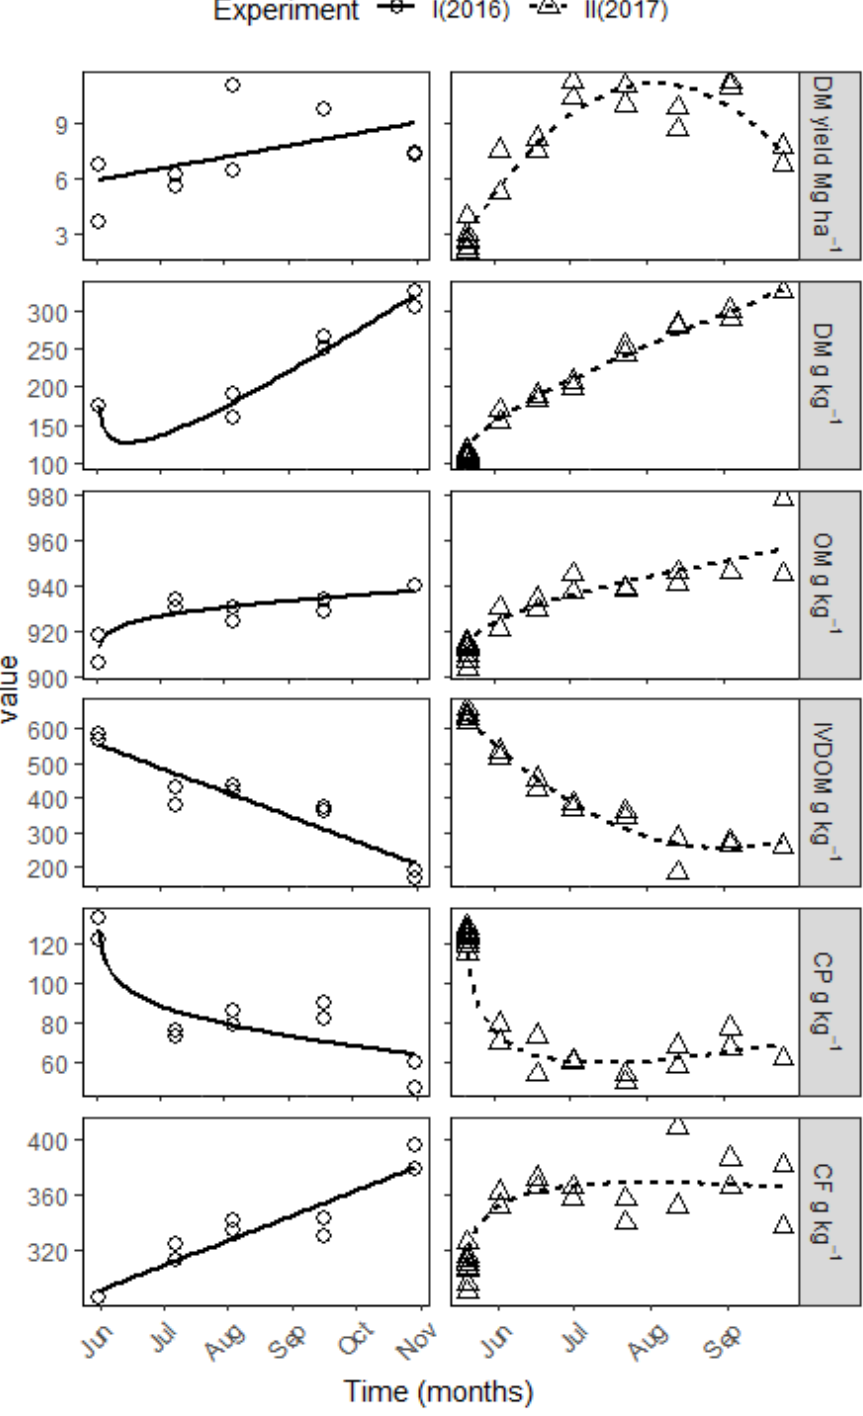
Figure 3. Experiments I and II: Effect of harvest day on dry matter (DM) yield and biomass DM, and on the dry matter contents of organic matter (OM), in vitro digestible organic matter (IVDOM), crude protein (CP) and crude fibre (CF) in T. latifolia biomass one year after planting. Harvest dates were 31 May, 07 July, 03 August, 15 September and 28 October 2016 for Experiment I and 19 May, 09 June, 16 June, 30 June, 21 July, 11 August, 01 September and 22 September 2017 for Experiment II. Each set of points per harvest date (n ≥ 2) represents the nutrient concentrations of biomass harvested for a first time in the growing season. In Experiment I DM contents of the 0 7 July harvest were not determined. Fit parameters of the curves are shown in Table